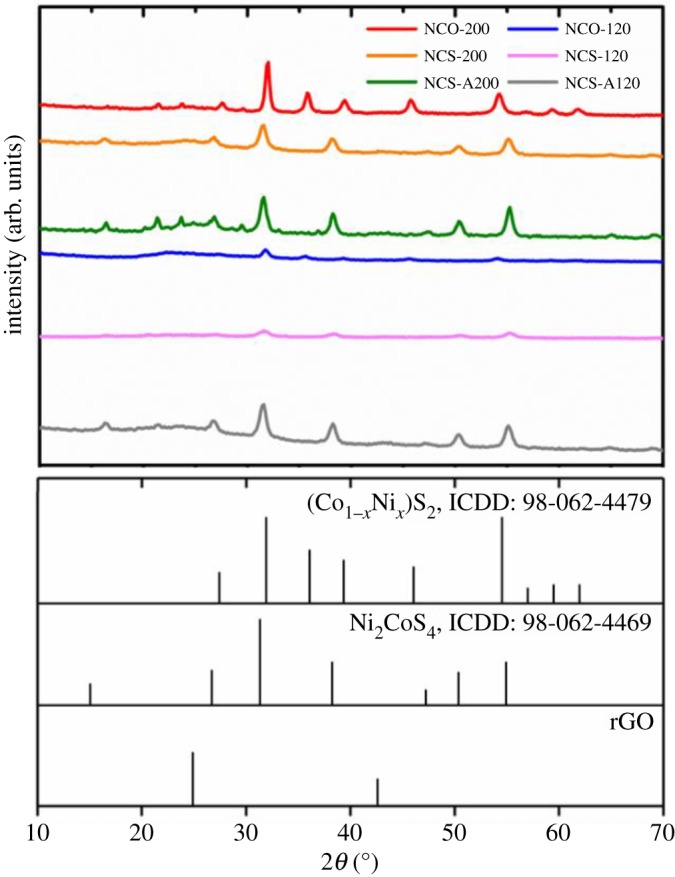
XRD patterns of NCO-200, NCS-200, NCS-A200, NCO-120, NCS-120 and NCS-A120 hybrids with the standard patterns of (Co1−xNix)S2 (ICDD: 98-062-4479), Ni2CoS4 (ICDD: 98-062-4469) and reduced graphene oxide (rGO).